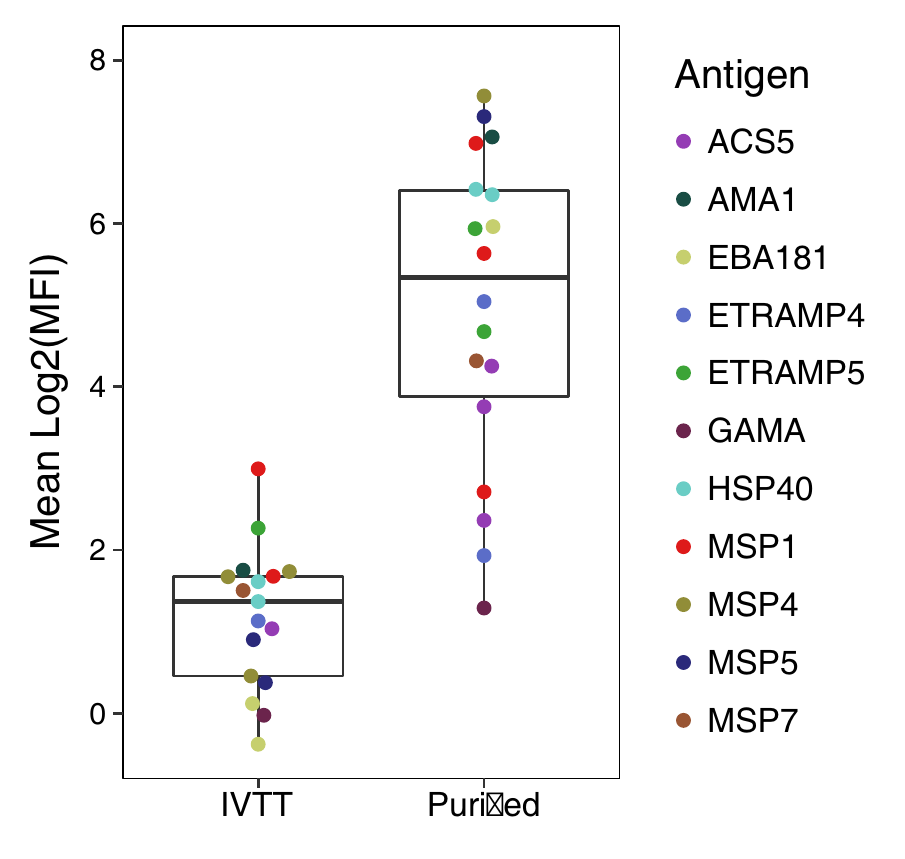
Fig 1. Mean magnitude of antibody responses to targets. The mean magnitude of response of each protein target stratified by expression system, presented with median and interquartile range of all mean responses.